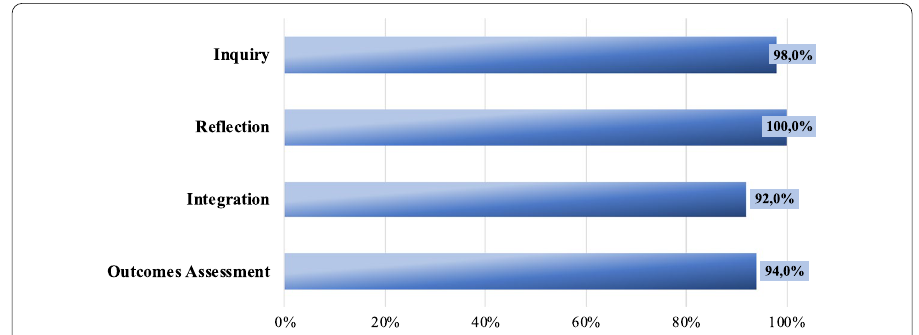
Fig. 4 Student perceptions of pedagogical principles fostered by the ESMC. Total students: 50. Percentage of agreement based on a 1–7 scale (1